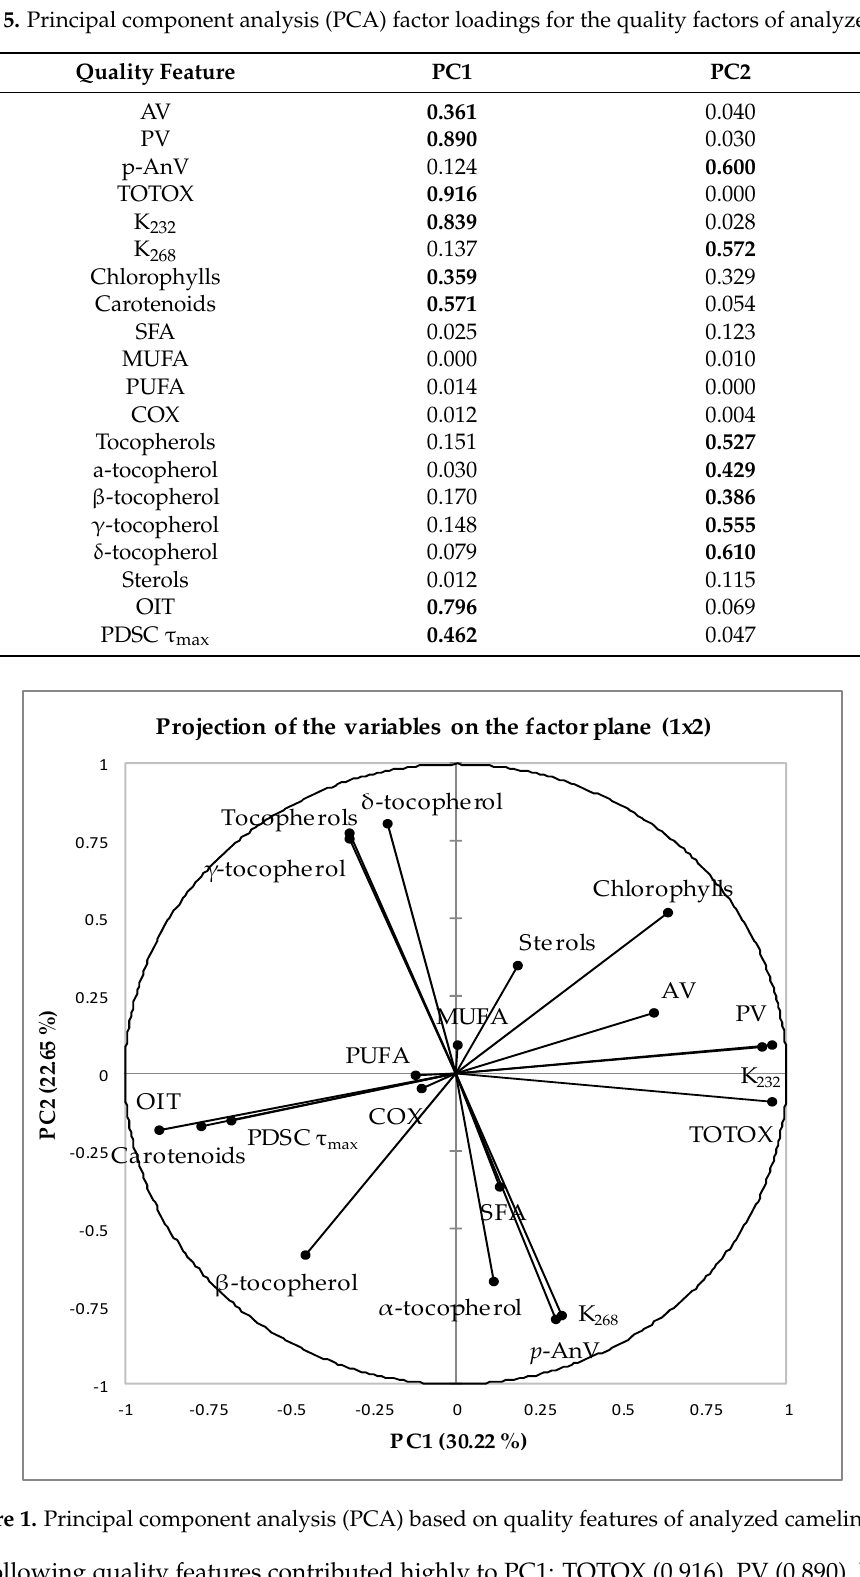
Table 5. Principal component analysis (PCA) factor loadings for the quality factors of analyzed oils.